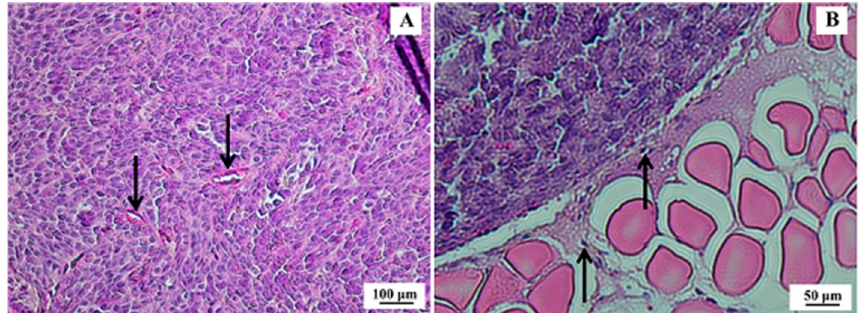
Figure 6. Histological section of SK-BR-3 breast tumor. ( A ) Presence of a dense tumor mass indicating high mitotic activity and cellular pleomorphism with some cuboid cells; however, with a higher frequency of spindle cells and scarce basophilic cytoplasm (100 × magnification)—arrows indicate tumor vessels. ( B ) Border region of the tumor (strongly acidophilic cell mass) and muscle tissue (200 × magnification)—arrows indicate tumor cells migrating to muscle tissue. Hematoxylin & eosin (H&E)